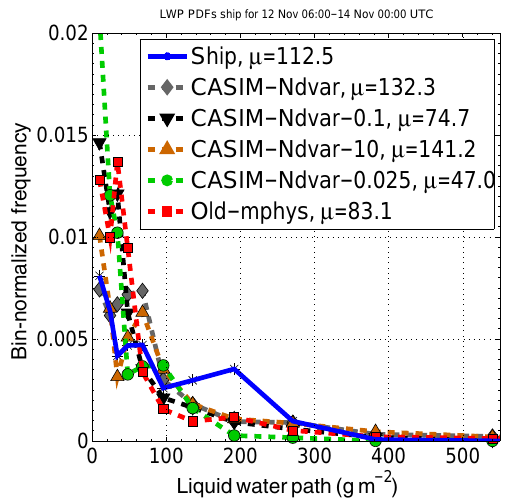
Figure 10. Cloud fraction cumulative distribution functions be- tween 08:12 and 16:12LST for the model and 07:57 and 15:57 for GOES-10 sampled every 30min. Here each cloud fraction value is calculated as the fraction of data points with LWP greater than 20gm − 2 relative to the total number of data points in 0.25 ◦ × 0.25 ◦ areas. GOES-10 data are used at the native 4km resolution and the model LWP data are first coarse-grained to this resolution from the native 1km